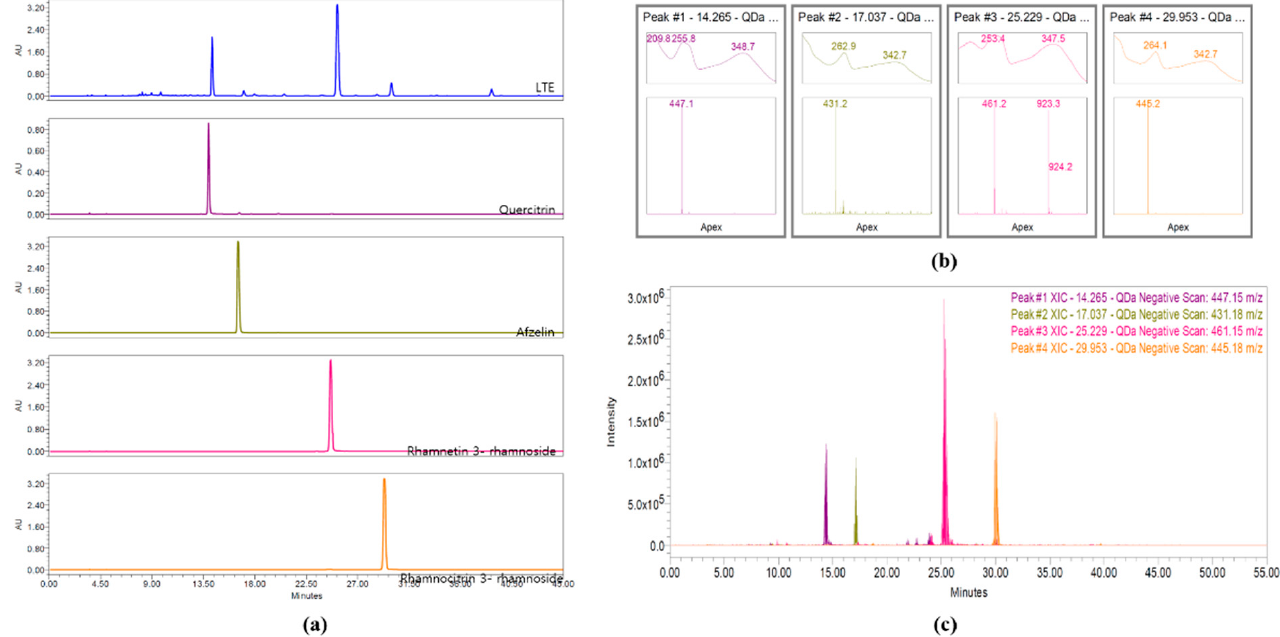
Figure 1. Analysis of ingredients of LTE. ( a ) HPLC chromatogram of LTE and active molecules at 254 nm, ( b ) verification of four main peaks comparing λ max , m / z for [M − H] − ; quercitrin (purple, λ max = 255.8, m / z = 447.1), afzelin (olive green, λ max = 262.9, m / z = 431.2), rhamnetin 3-rhamnoside (pink, λ max = 253.4, m / z = 461.2), and rhamnocitrin (orange, λ max = 264.1, m / z = 445.2), and ( c ) overlay of four SIR peaks in LTE; quercitrin (purples; 14.265 min, m / z = 447.15), afzelin (olive green, 17.037 min, m / z = 431.18), rhamnetin 5-rhamnoside (pink, 25.229 min, m / z = 461.15), and rhamnocitrin (orange, 29.953 min, m / z = 445.18).